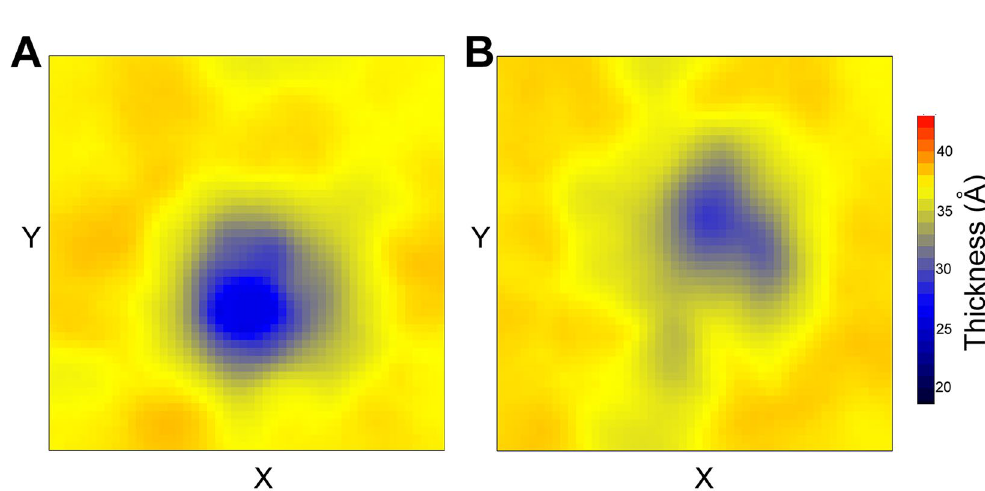
Figure 7. The average membrane thickness over the last 100 ns simulation time. ( A ) Membrane bounded with the β NC intermediate; ( B ) Membrane bounded with H intermediate. The thicknesses are calculated the distance between the phosphate group on the opposite layer of the